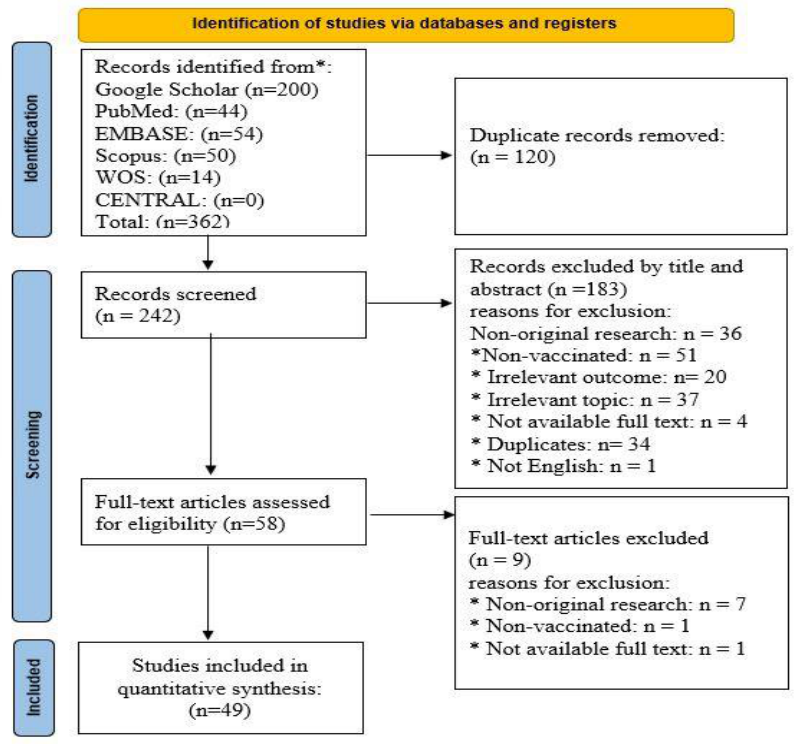
Figure 1. PRISMA chart for article selection. *: the following different databases